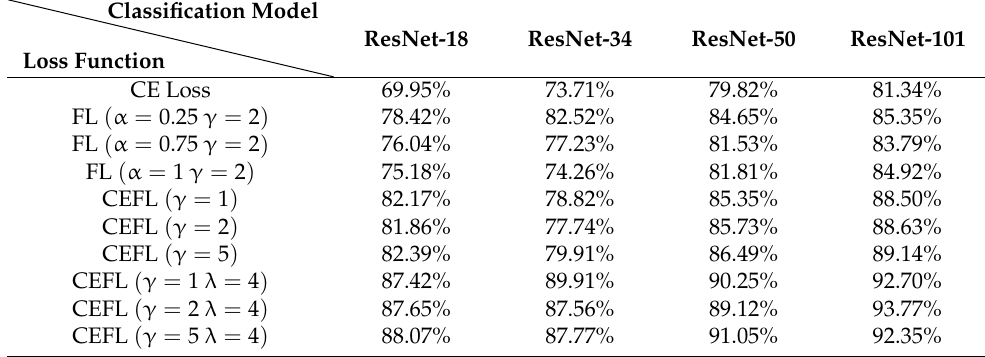
Table 4. Accuracy rates based on different loss functions of various ResNets.